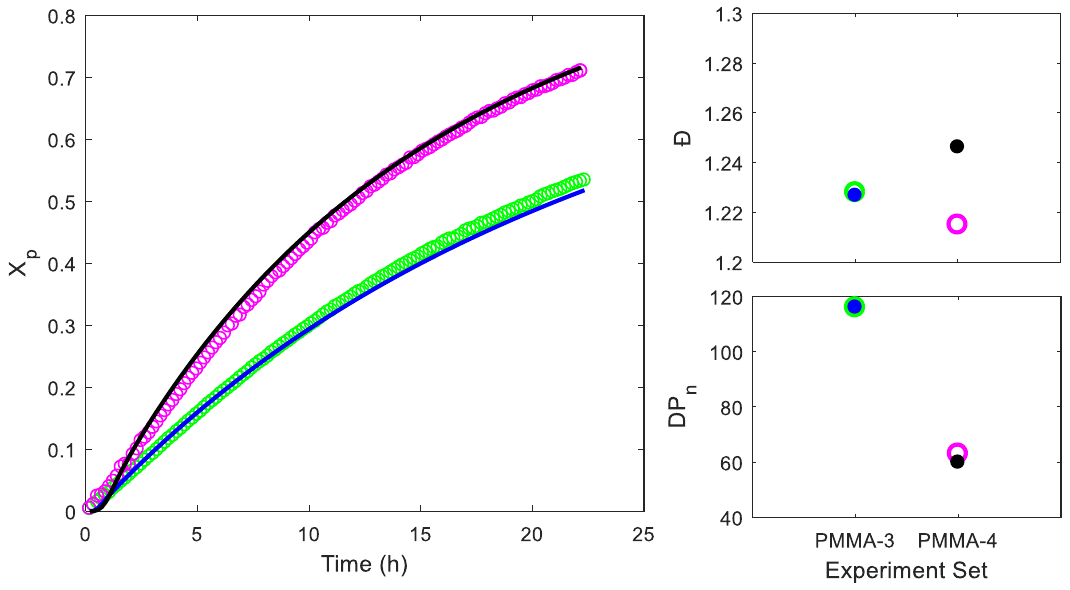
Figure 6. Experimental data obtained from small-scale reactions versus optimal fitting results. (Green circles are the data collected from PMMA-3 set and magenta ones are from PMMA-4 set. The solid symbols represent the Ð and DP n estimated from the